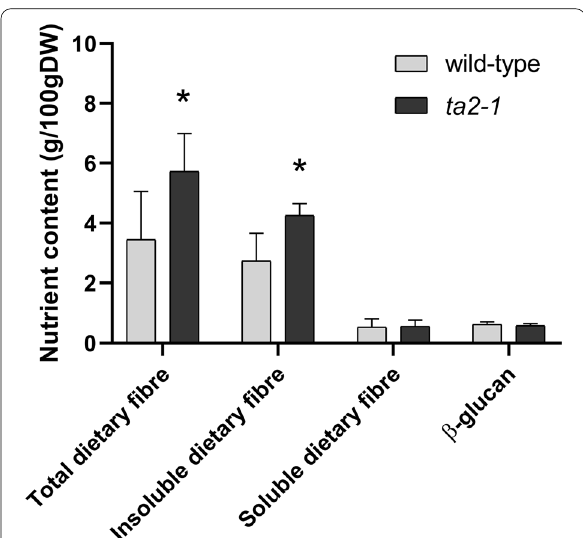
Fig. 5 Total, insoluble, soluble dietary fibre, and β‑glucan comparison (* P < 0.05; ANOVA, Tukey’s HSD test, total dietary fibre, n 8; insoluble = dietary fibre, n 5; soluble dietary fibre, n 5; β‑glucan, n 3). The = = = exact p‑value of all the statistical analyses in this study can be found in the file of Fig. 5‑12_RawData.xlsx in the supplementary